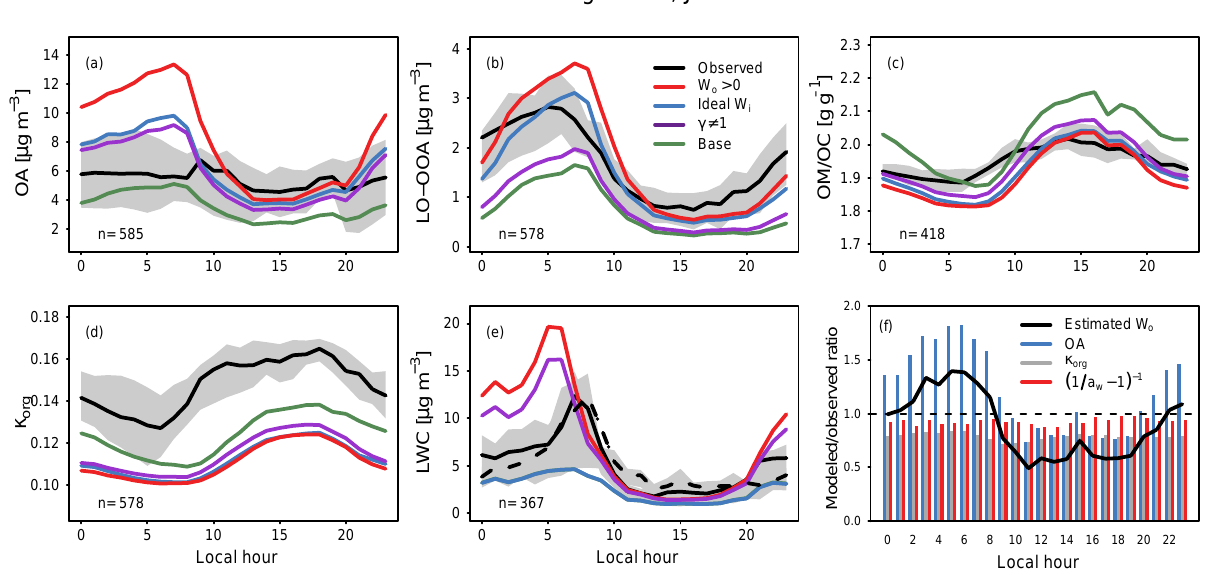
Figure 11. Observed and predicted concentration of (a) organic aerosol (Xu et al., 2015a), (b) AMS LO-OOA factor (Xu et al., 2015a) and model-predicted organic-nitrate-derived SOA, (c) OM / OC (Hu et al., 2015), (d) κ org , (e) aerosol liquid water measured by nephelometer and the Georgia Tech group (solid black) (Guo et al., 2015) and measured by particle growth and the Rutgers/NC State group (dashed black) (Nguyen et al., 2014b), and (f) ratio of predicted to observed quantities influencing organic water ( W o ) at CTR (for the γ (cid:54)= 1 simulation only). Observed κ org is determined by applying a κ org ,i value of 0.31, 0.20, 0.16, and 0.08 to observed BBOA, isoprene-OA, MO-OOA, and LO-OOA, respectively (Cerully et al., 2015). Grey shading represents the interquartile range of the observed data (mean in black). Colors represent different simulations in (a) – (e) and different quantities in (f)